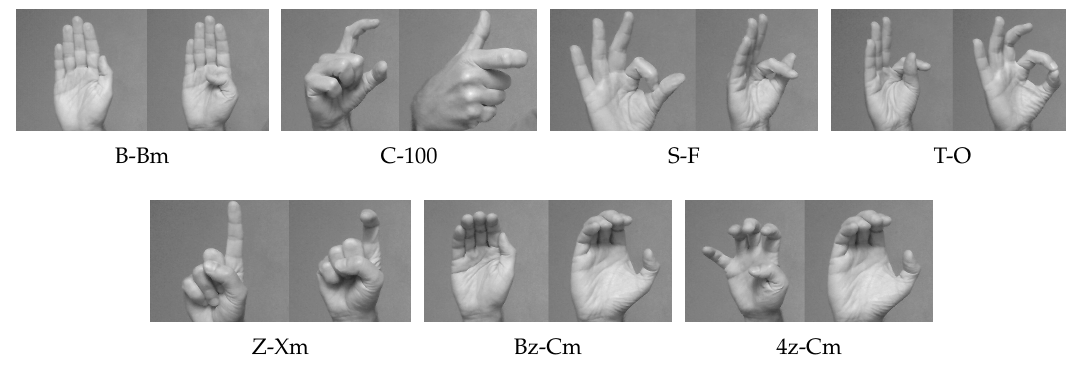
Figure 3. The most often confused postures of Dataset